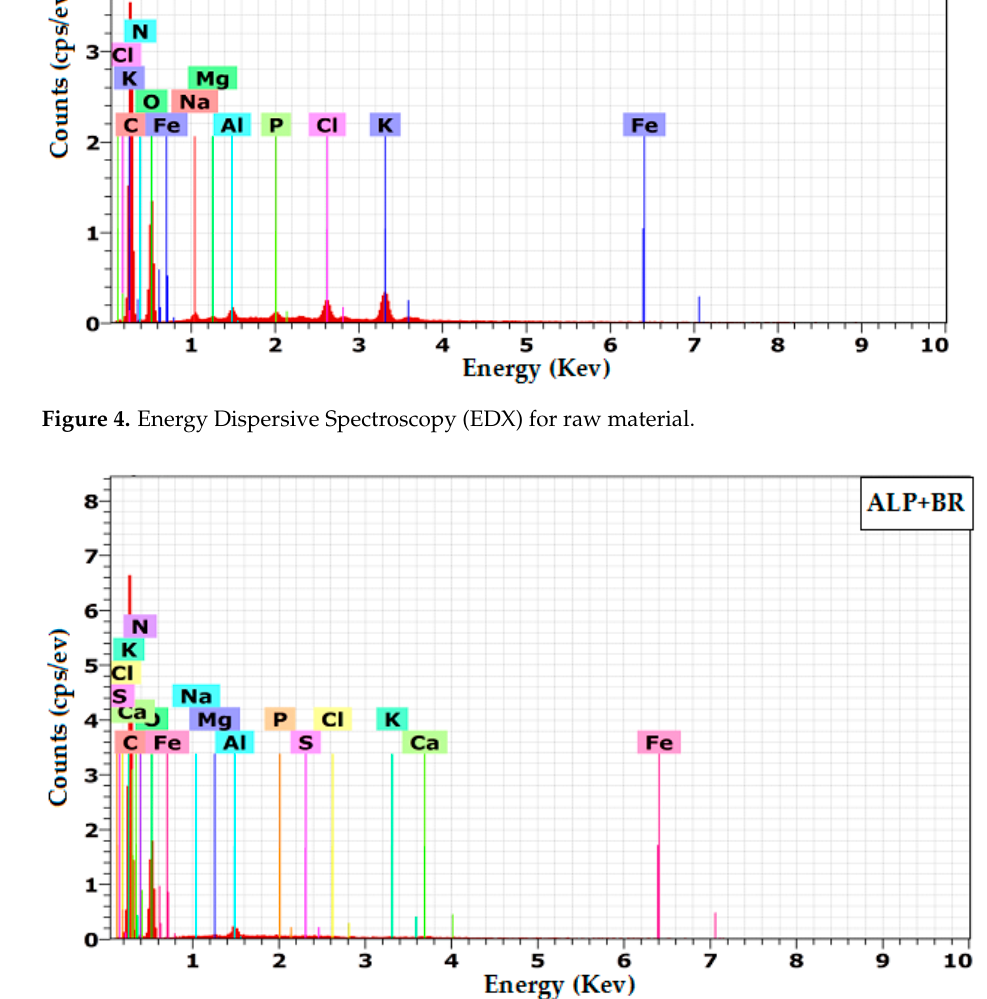
Figure 5. Energy Dispersive Spectroscopy (EDX) after adsorption.